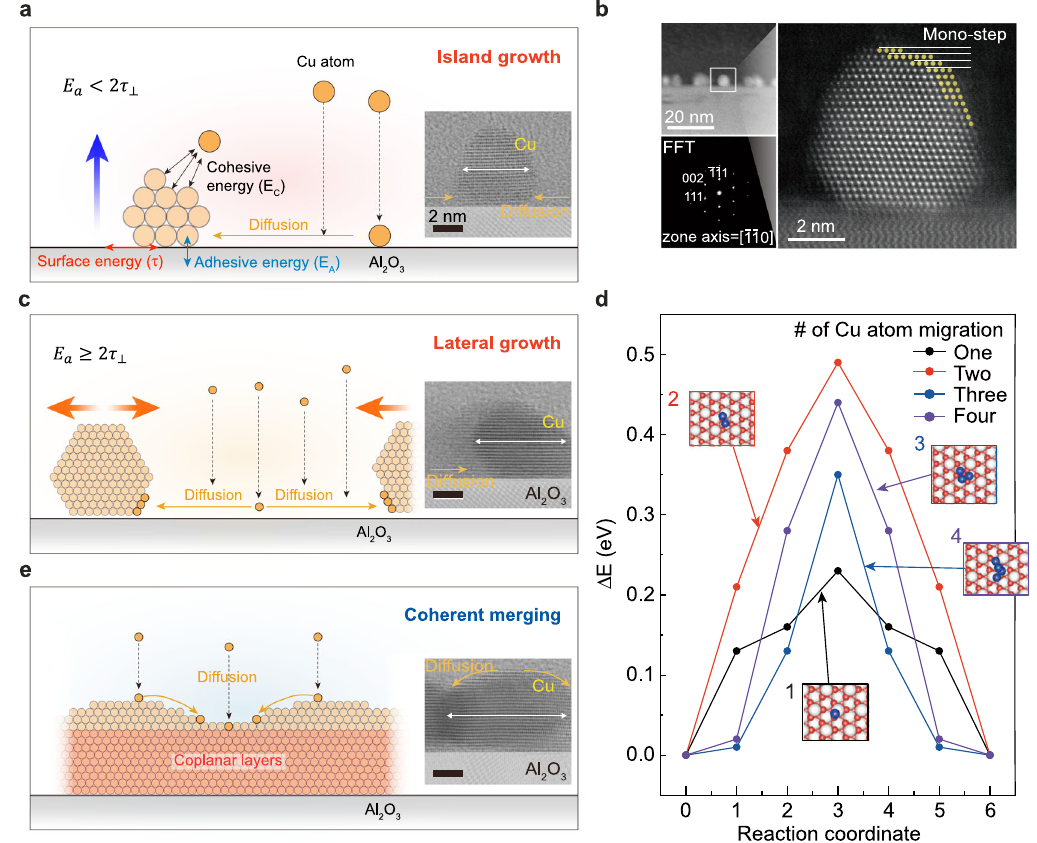
Fig. 5 | Theoretical approach for coherent consolidation of nucleations into a coplanar layer. a Scheme for the growth of a single nanodroplet via atomic dif- fusion, and corresponding bright fi eld scanning transmission electron microscopy (BF STEM) image. b High-resolution scanning transmission electron microscopy (HRSTEM) image and fast Fourier transform pattern (inset) of a Cu nanodroplet oriented along the ½ 1 (cid:1) 10 (cid:2) zone axis, indicating single-crystal nanodroplet growth